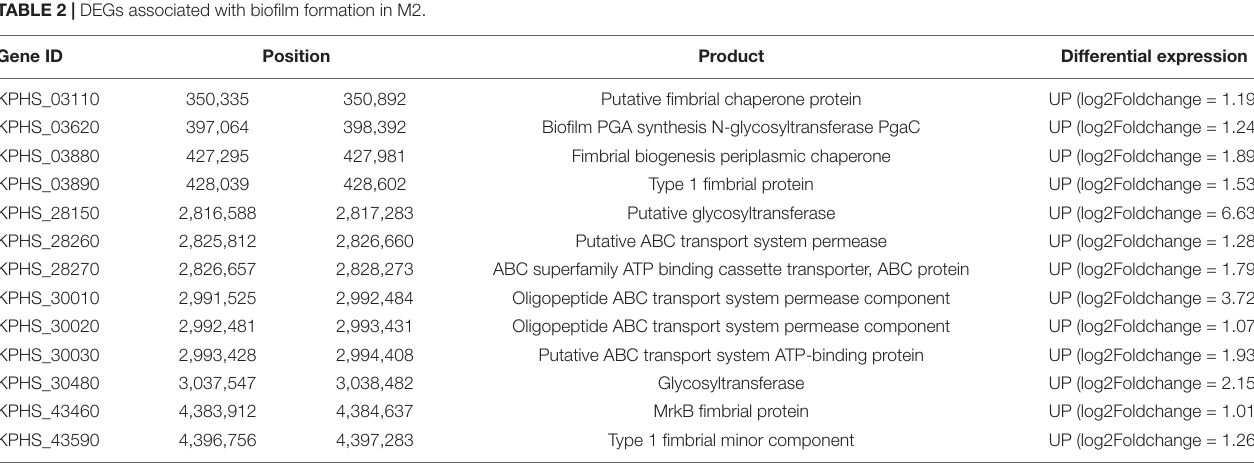
FIGURE 3 | Functions of DEGs. (A,B) Classification of up-regulated genes in M1 and M2 compared with WT, respectively. In GO enrichment analysis, BP, CC, and MF are the categories of Gene Ontology, representing biological processes, cellular components, and molecular functions, respectively. TABLE 2 | DEGs associated with biofilm formation in